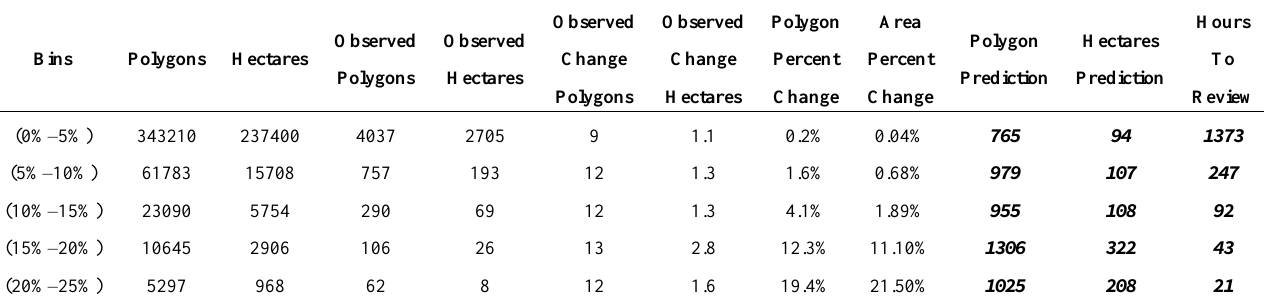
Table 3. Omission analysis extent, effort, observations and predictions for different predicted change probabilities in sample-only bins. The observed polygons consisted of the Omission samples. Columns show the areal extent and polygon count for each bin, the polygons observed and the number of polygons observed as omitted change. The last three columns in italics are predictions based on observed proportions. Predictions can be made by using either the proportion of observed polygons that changed or the proportion of area observed that changed. Review hours are based on a rate of 250 polygons per